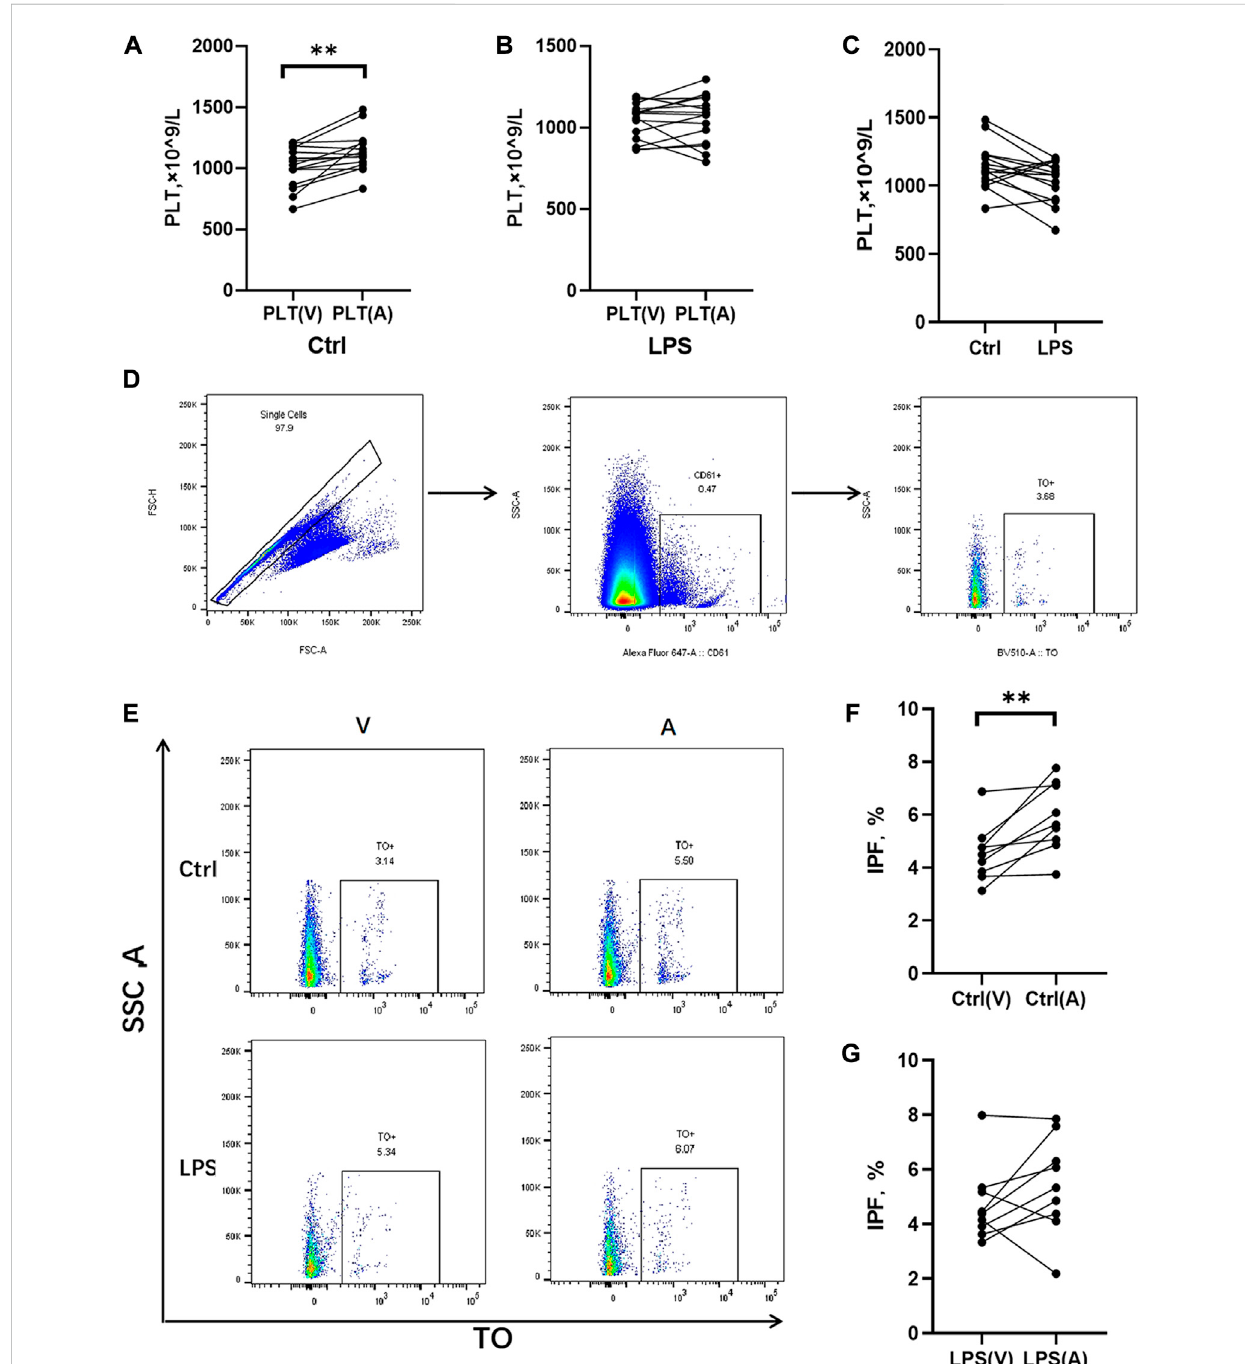
FIGURE 5 Platelet counts and IPF in prepulmonary and postpulmonary blood of the LPS-induced ARDS groups and the controls. (A) Prepulmonary and postpulmonary platelet counts in the control group; (B) Prepulmonary and postpulmonary platelet counts in the LPS-induced ARDS group, PLT(V): Prepulmonary platelet counts; PLT(A): postpulmonary platelet counts. (C) The peripheral blood platelet counts in the LPS-induced ARDS and control groups. (D,E) The strategy for gating cells in the process of analysing the immature platelet fraction (IPF). Brie fl y, the single cells were gated from all the cells in the prepulmonary and postpulmonary blood, and then CD61 + cells were gated prior to obtaining the IPF with TO+. (F) Prepulmonary and postpulmonary IPF in the control group; (G) Prepulmonary and postpulmonary IPF in the LPS-induced ARDS group. * p < 0.05, ** p <